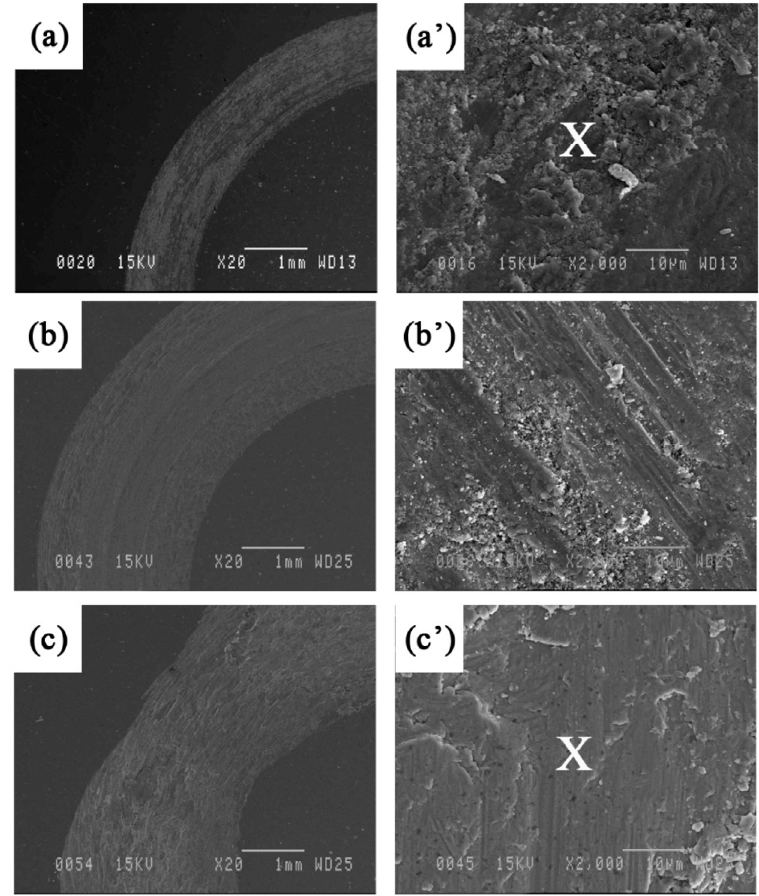
Figure 10. SEM images at different magnifications of the worn surfaces for Fe 3 Al at a sliding speed of ( a and a’ ) 0.04, ( b and b’ ) 0.1 and ( c and c’ ) 0.8 m s − 1 under a load of 5 N. EDS was taken from the points marked by X.